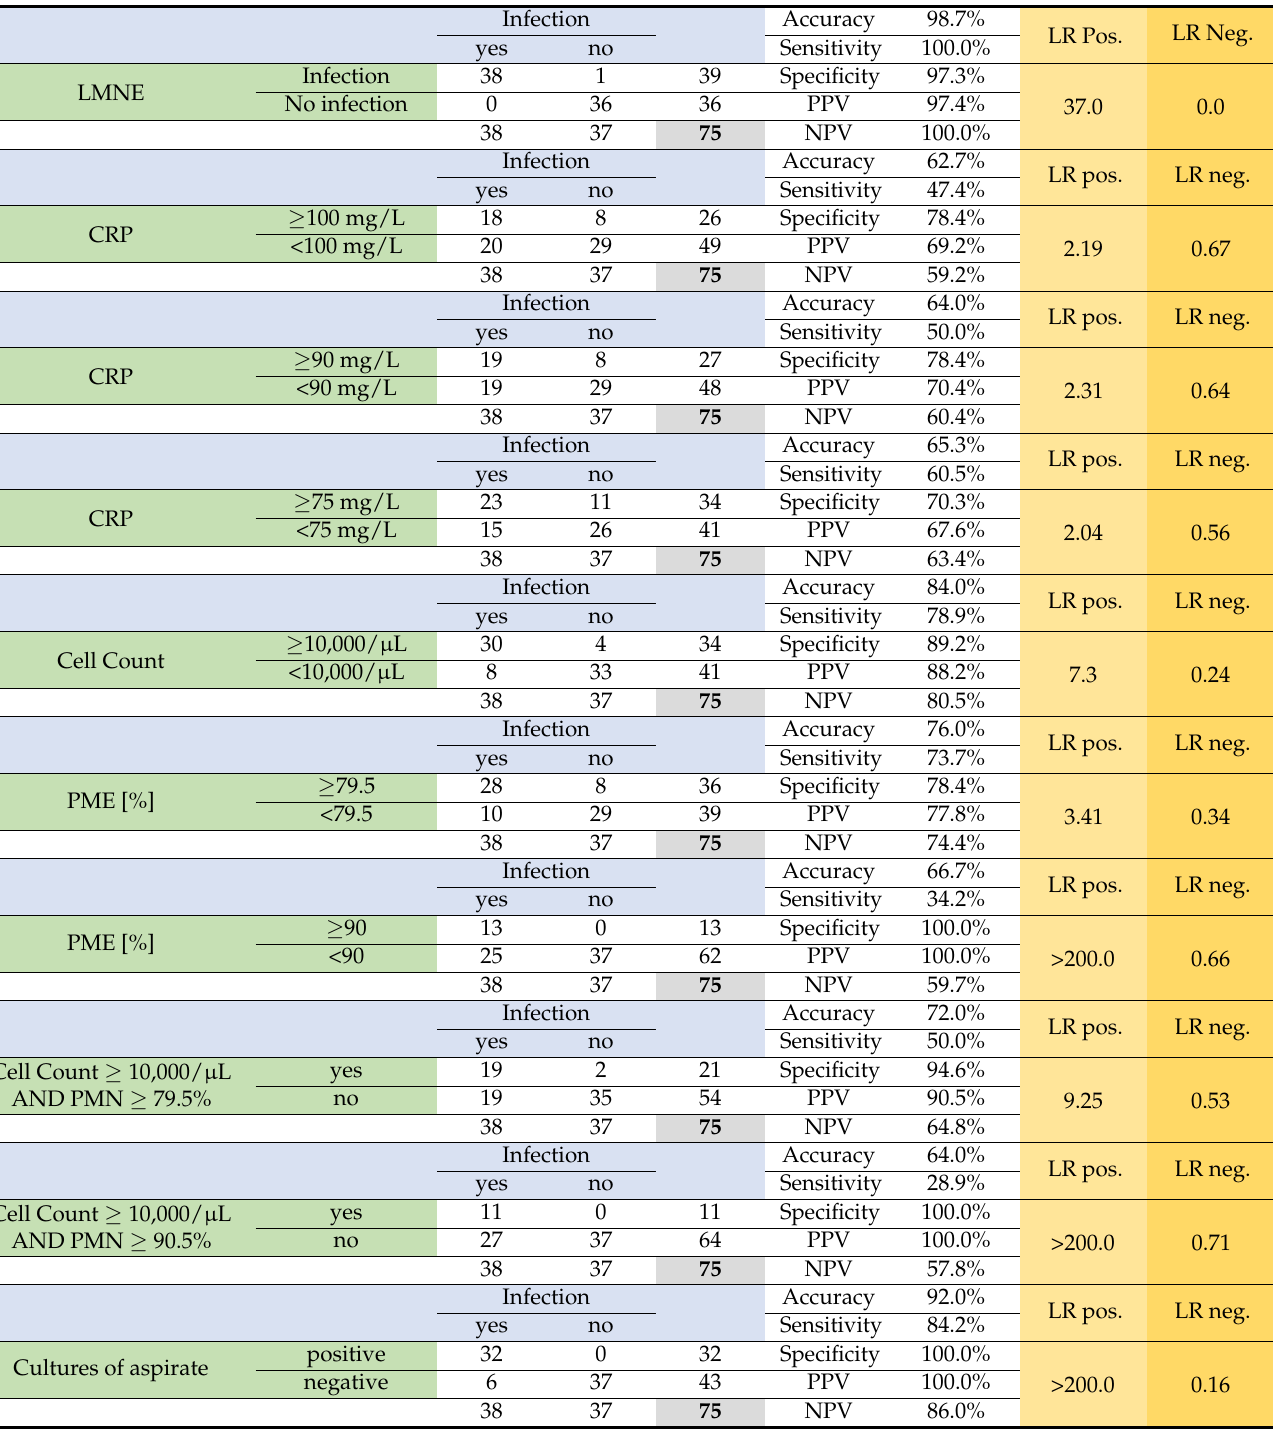
Table 2. Diagnostic values for the different parameters with different